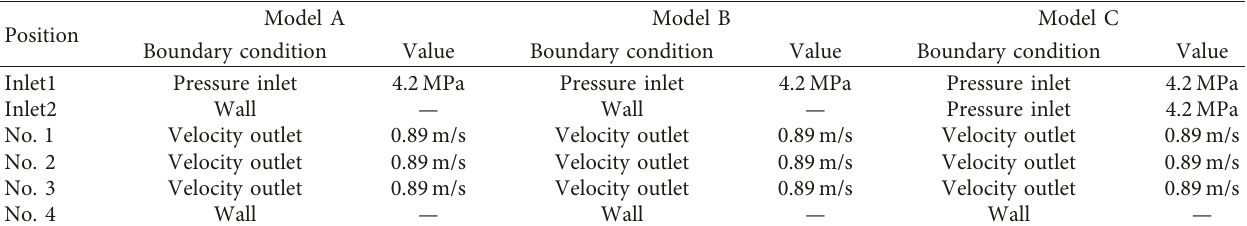
Figure 9: The first frequency and mode shape of the inlet pipeline modifications. (a) Model A; (b) model B; (c) model C. Table 2: Boundary conditions of the inlet pipeline modification models for CFD